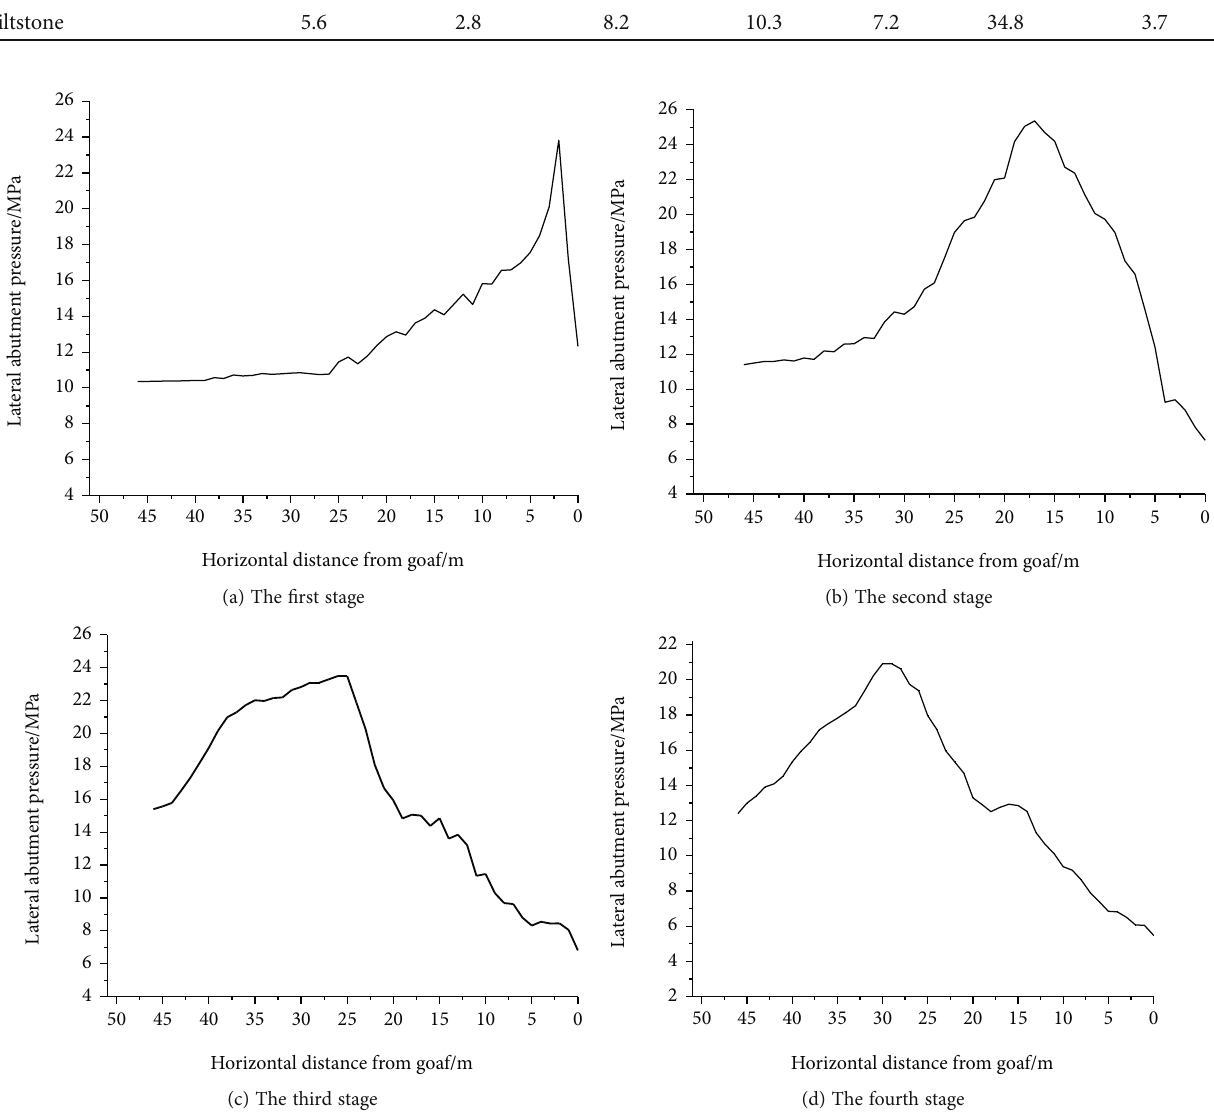
Figure 9: Structural characteristics of overburden movement and dynamic distribution curve of lateral abutment pressure in di ff erent